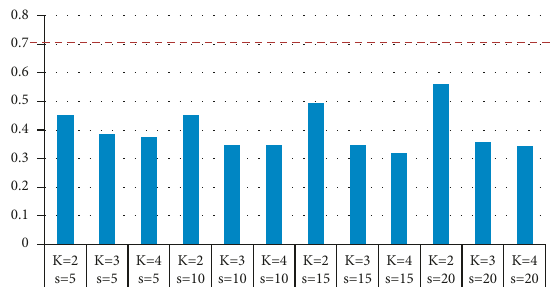
Figure 12: Specificity of CBCD on BAC with a threshold 0.005.